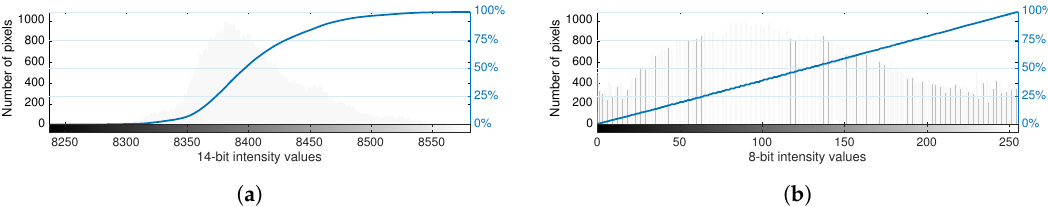
Figure 2. Automatic gain control with histogram equalization: ( a ) the raw data histogram is used to compute the cumulative distribution function (in blue) for the bounds of the 14-bit intensity values; ( b ) the data are compressed to 8-bit by flattening the distribution of the compressed data histogram, resulting in an approximate linear cumulative distribution function (in